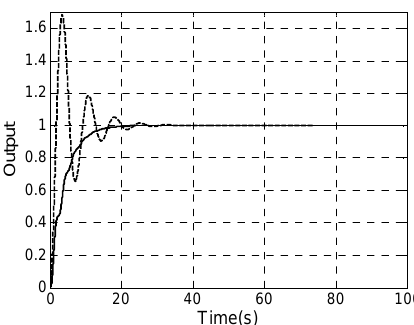
Fig. 11. Step responses of a marginally stable plant with the T-S PI fuzzy controller (solid line) and traditional PI controller (dash line).